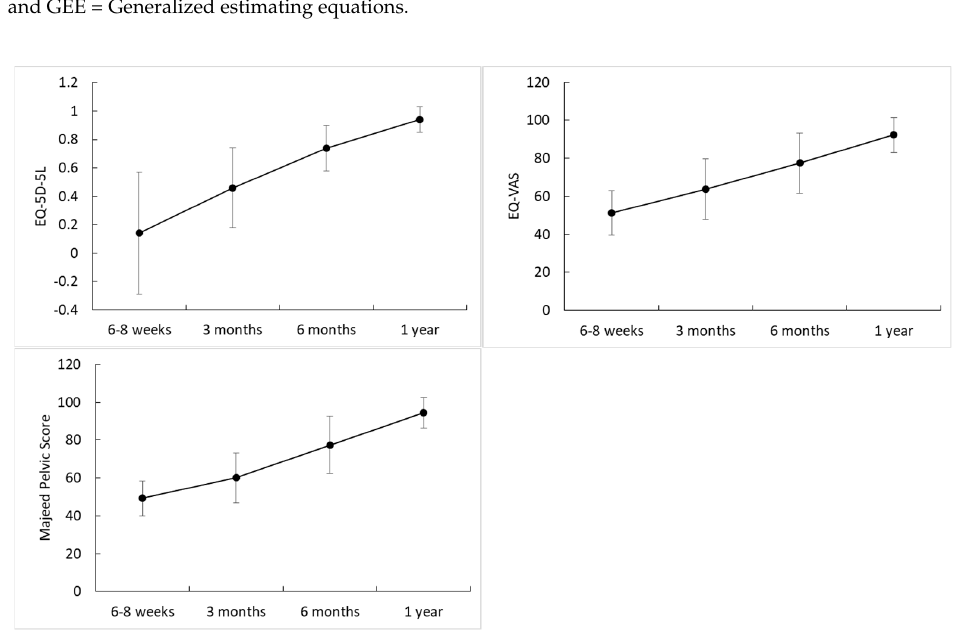
Figure 6. EQ − 5D − 5L, EQ − VAS, and Majeed pelvic scores over time.